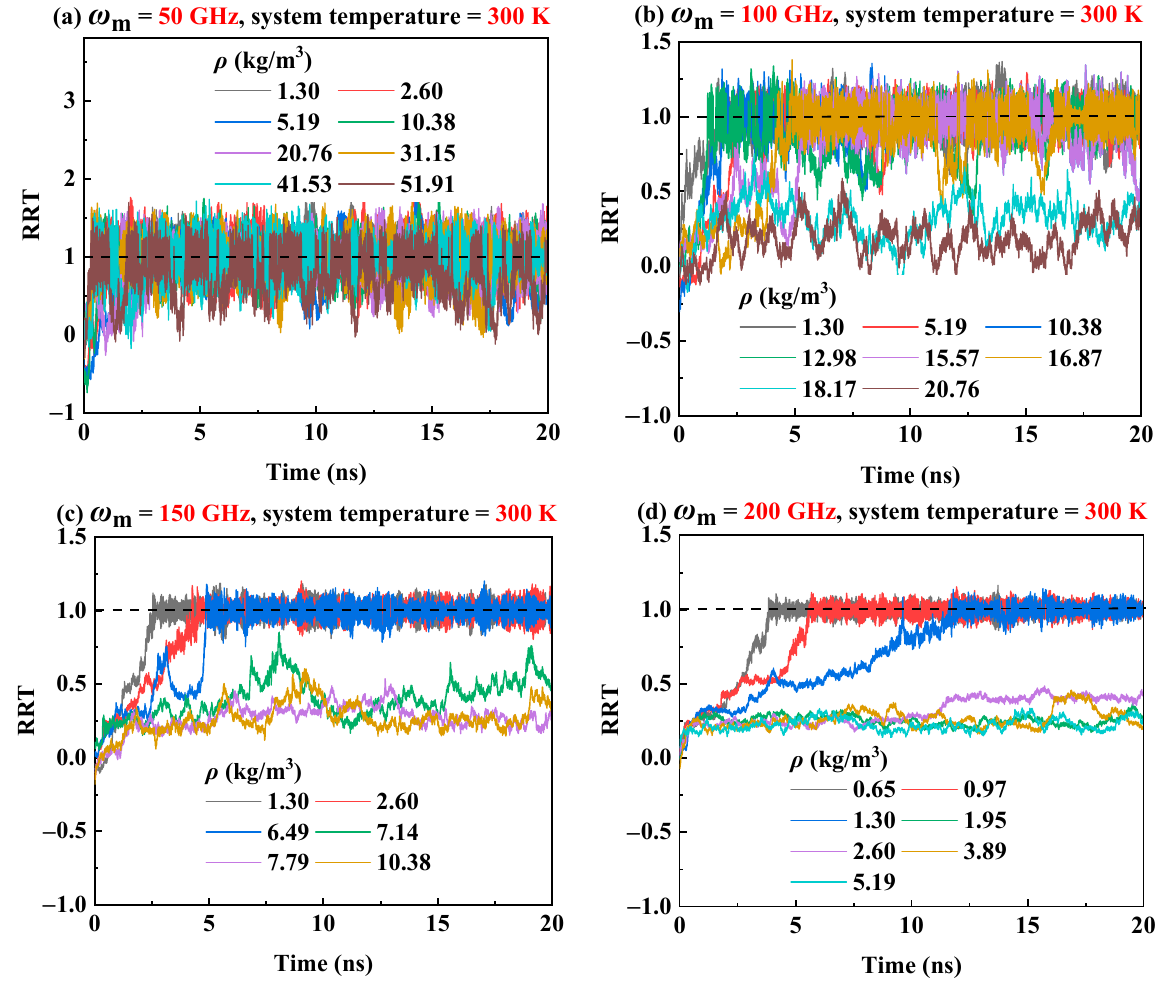
Figure 3. Time histories of RRT at 300 K with different helium densities and motor input rotation frequencies: ( a ) ω m = 50 GHz, ( b ) ω m = 100 GHz, ( c ) ω m = 150 GHz, and ( d ) ω m = 200 GHz.